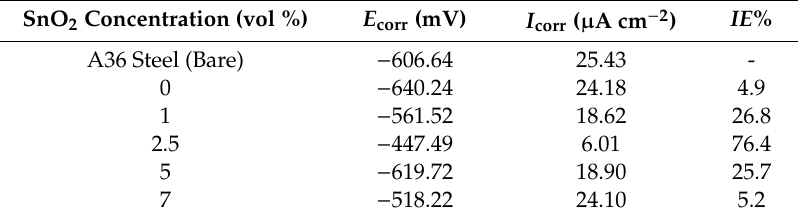
Table 3. The corrosion parameters obtained from the polarization Tafel method.